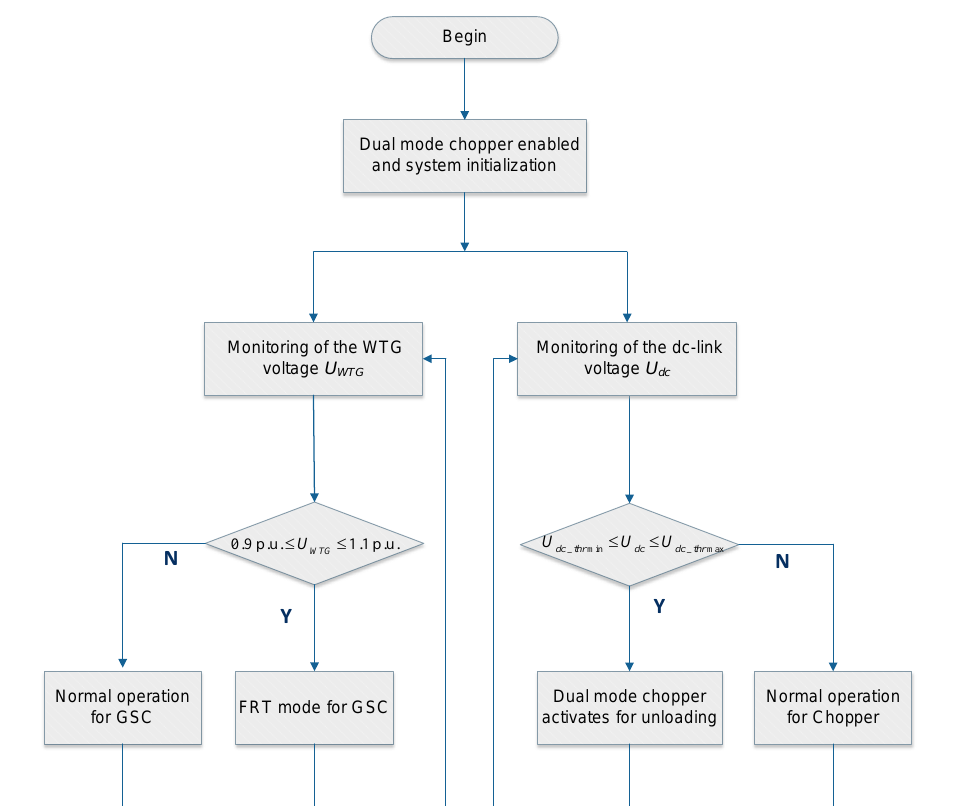
Figure 8. Comprehensive structure of the coordinated high voltage ride-through (HVRT) and low voltage ride-through (LVRT) control strategy.